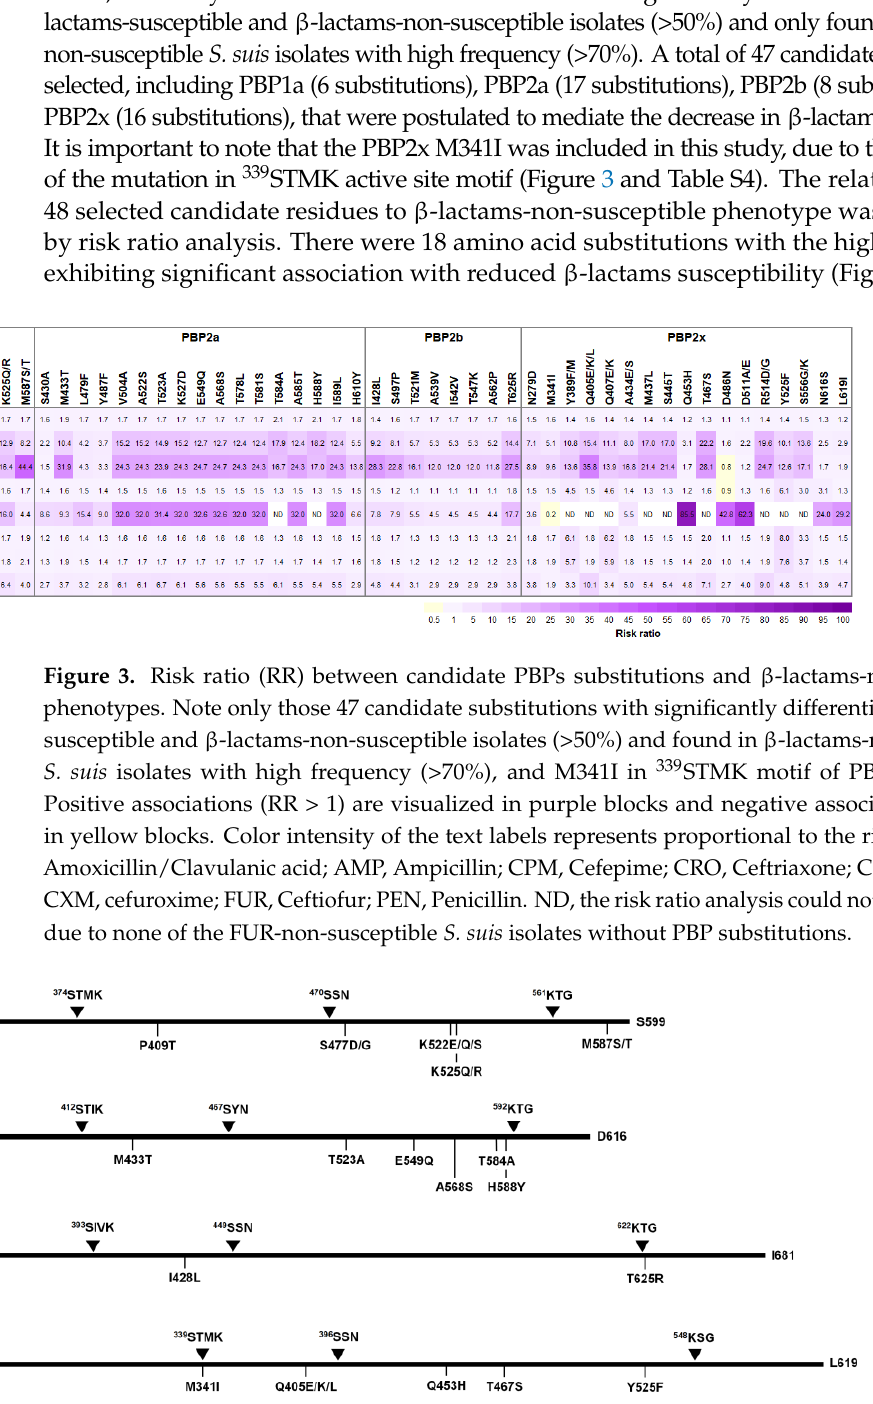
Figure 4. Schematic diagram presenting the major substitution sites implicated in β -lactams-non- susceptibility.